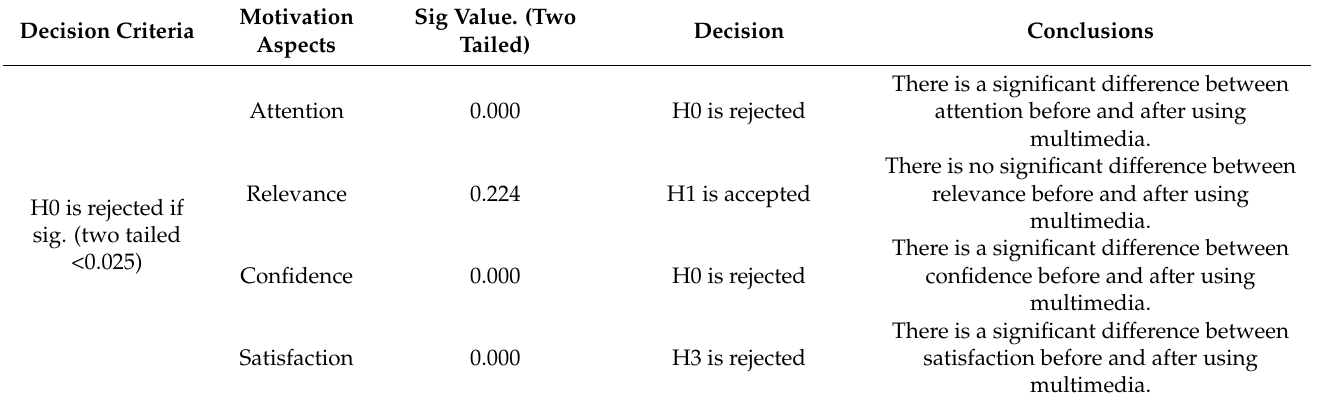
Table 9. Test results for the significance of the paired sample t